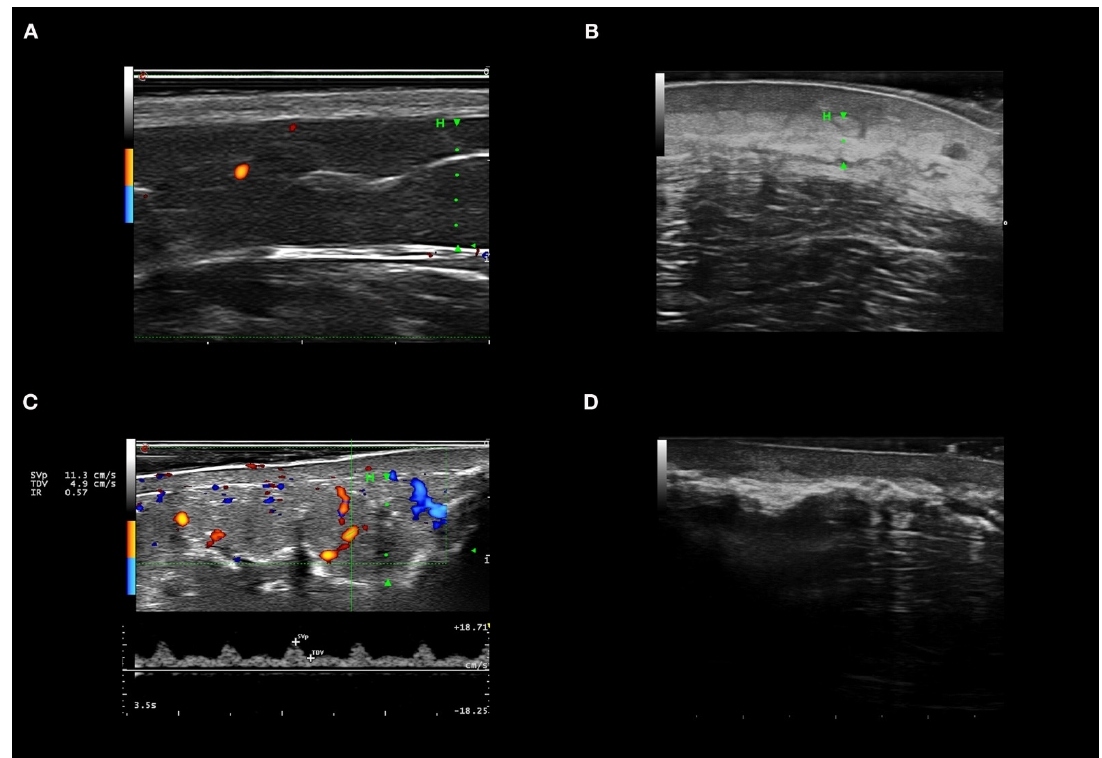
Figure 2. High-frequency ultrasound in autoimmune panniculitis. ( A ) Healthy skin in color Doppler mode. ( B ) Inflamma- tion of dermis and hypodermis; the dermis is hypoechoic, and the hypodermis with hyperechoic lobules in B mode. ( C ) Panniculitis with hyperechogenicity of lobules and marked increase in flow in color Doppler mode. ( D ) Extensive calcium deposits with posterior acoustic shadowing. In images A, B, and C, the hypodermis is marked with an H and a green line. In Figure 2D, the calcium deposits do not allow evaluation of the hypodermis as they produce a posterior acoustic shadow.